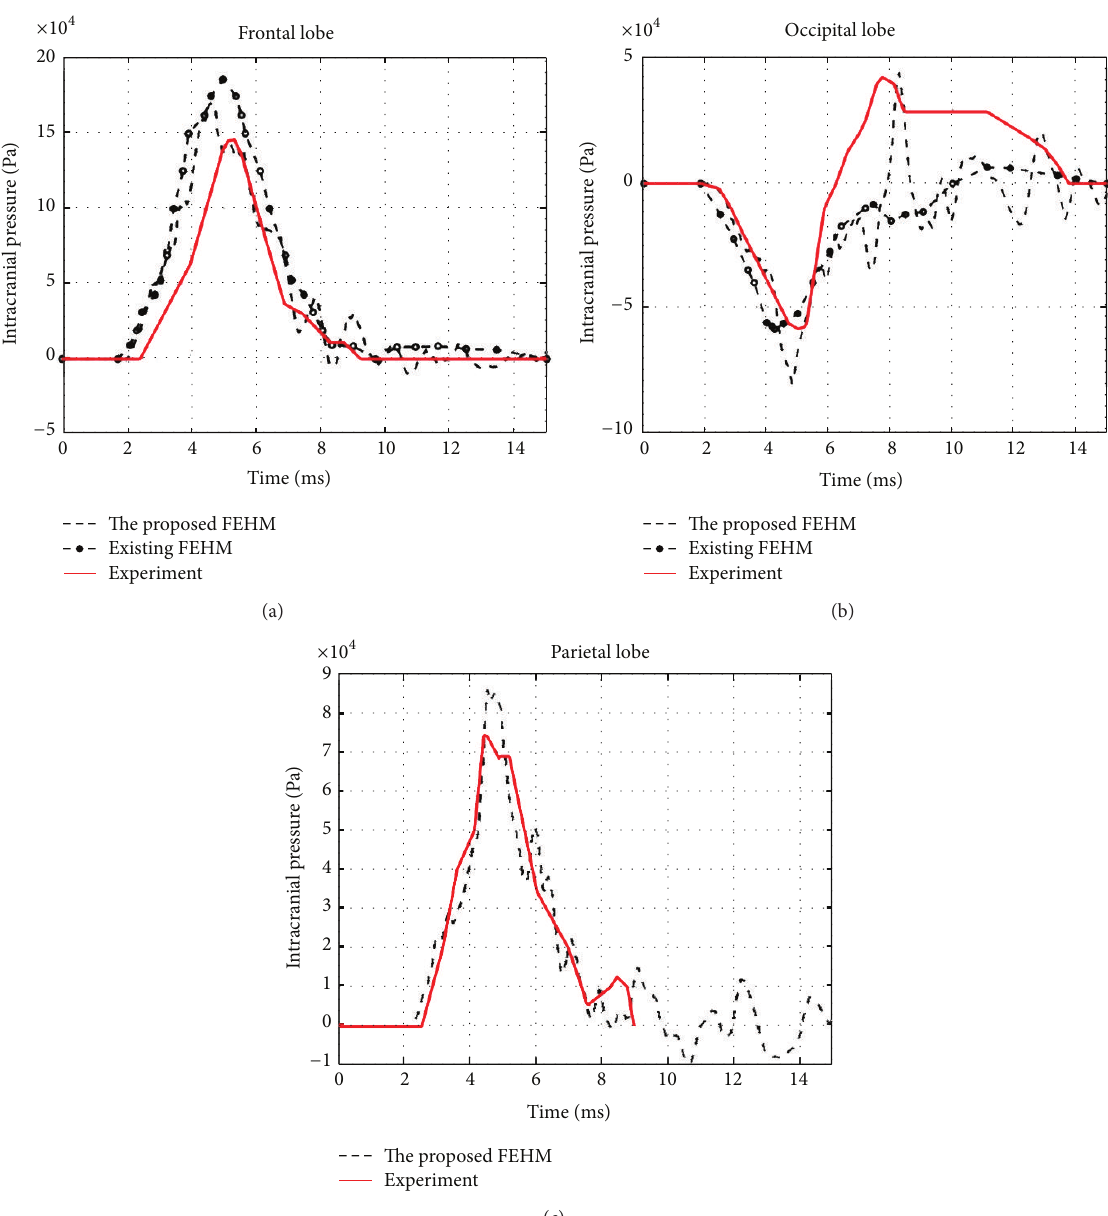
Figure 8: (a) Frontal pressure; (b) occipital pressure; (c) parietal pressure.